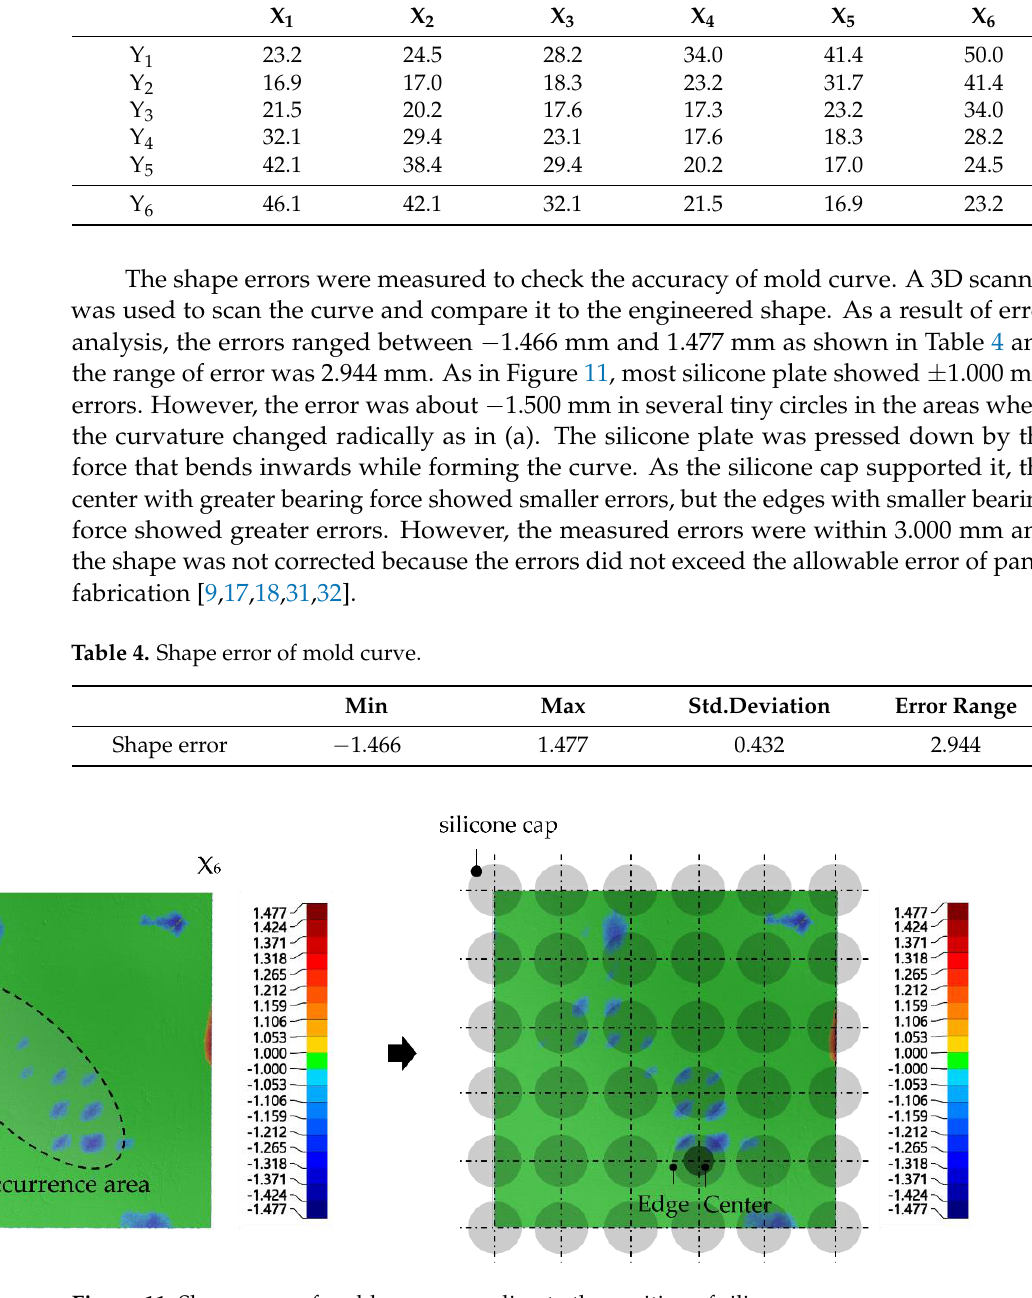
Figure 11. Shape error of mold curve according to the position of silicone cap.